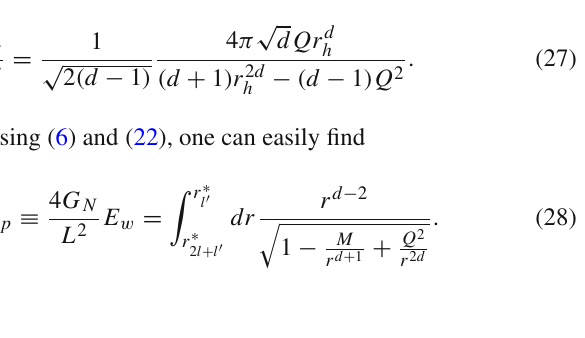
Fig. 4 The two top rows: the EoP with respect to μ l (cid:3) = 0 . 1 and different values of l . In the all of these diagrams T is fixed and equal to 0 .